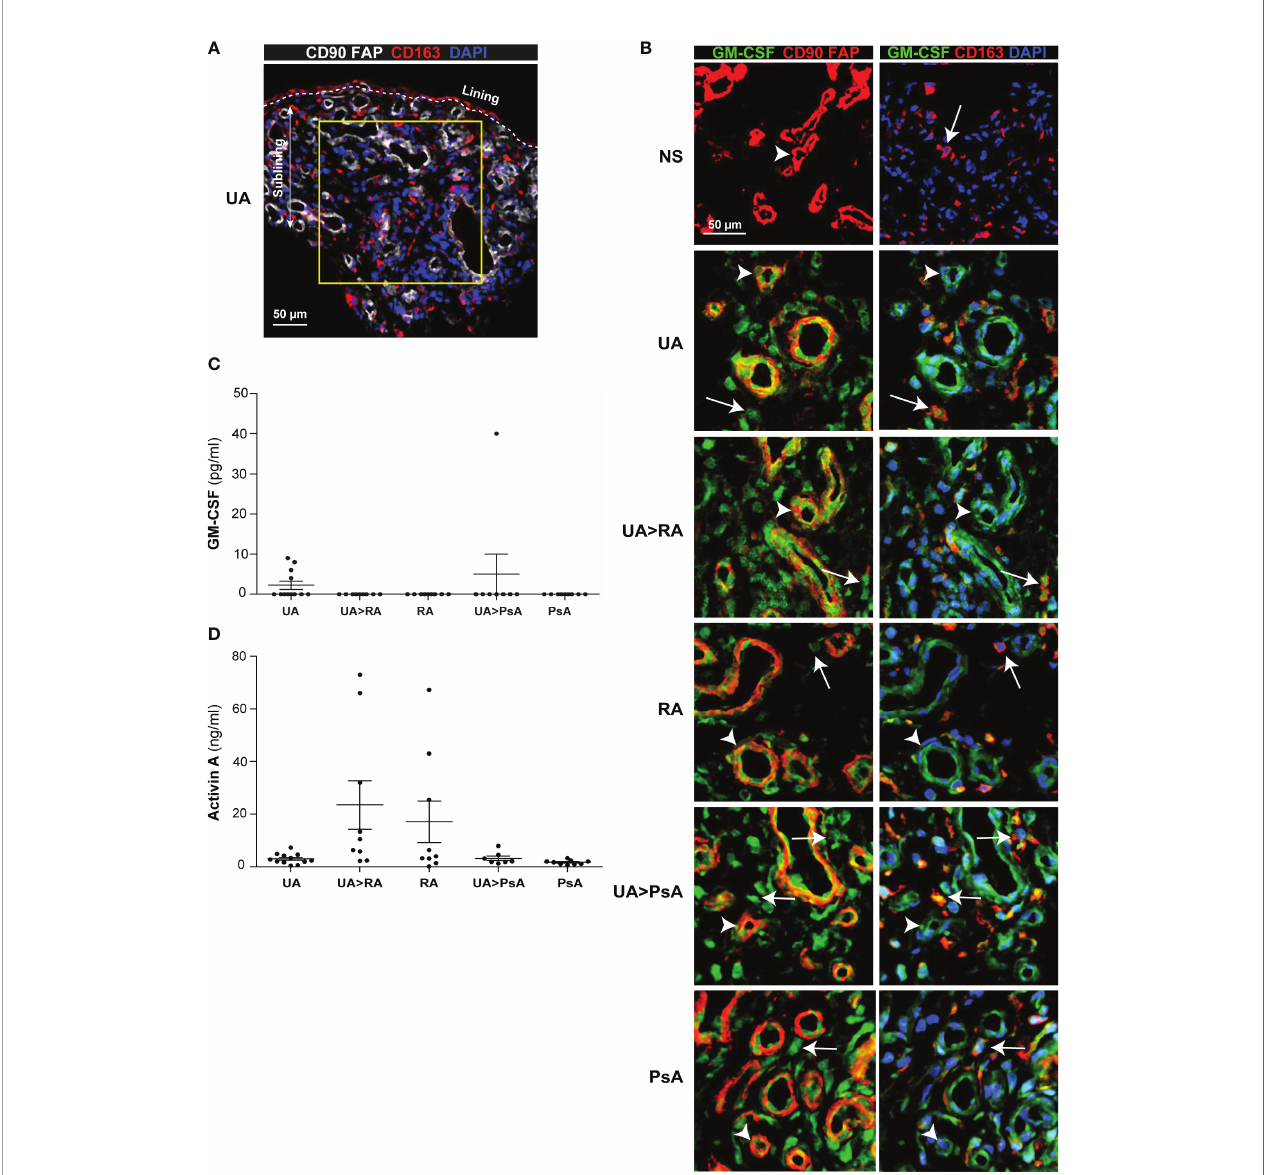
FIGURE 1 | GM-CSF expression in stromal cells from synovial tissue of undifferentiated arthritis patients. (A) Representative immuno fl uorescence image of persistent undifferentiated arthritis (UA) synovial tissue (ST) determined by confocal microscopy using anti-CD90, anti-FAP (white), and anti-CD163 (red)-speci fi c antibodies; nuclei were counterstained with DAPI. Lining and sublining layers are shown. The region of interest in the sublining layer (yellow square) is located 50 µm from the lining layer. (B) Immuno fl uorescence analysis of normal synovium (NS), persistent undifferentiated arthritis (UA), undifferentiated arthritis evolving to RA (UA>RA), rheumatoid arthritis (RA), undifferentiated arthritis evolving to psoriatic arthritis (UA>PsA) and psoriatic arthritis (PsA) ST determined by confocal microscopy using anti-GM-CSF (green), anti-CD90, anti-FAP or anti-CD163 (red)-speci fi c antibodies; nuclei were counterstained with DAPI. Arrowheads indicate CD90 + FAP + fi broblast and white arrows indicate CD163 + macrophages. Samples were devoid of staining when incubated with isotype-matched irrelevant antibodies as negative controls. The experiment was carried out in independent samples from each type (NS, n=6; UA, n=16; UA>RA, n=8; RA, n=12; UA>PsA, n=9; and PsA, n=10) and representative experiments are shown. CD163 + macrophages are indicated by white arrows. Scale bars, 50 µm. Determination of levels of GM-CSF (C) and activin A (D) in the synovial fl uid of patients with UA (n=12), UA>RA (n=9), RA (n=9), UA-PsA (n=7), and PsA (n=9), as determined by